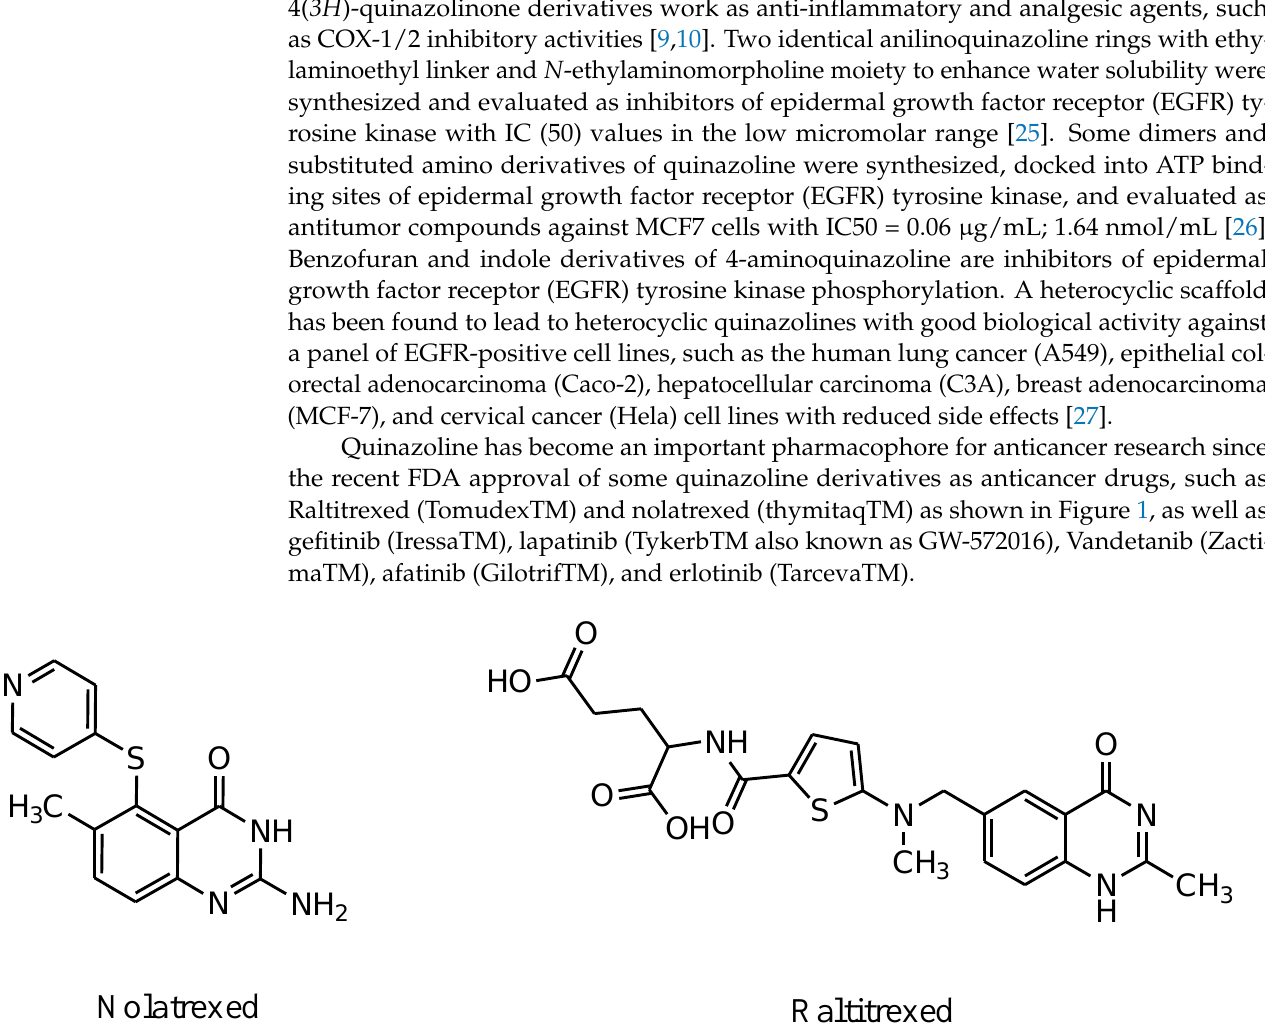
Figure 1. Chemical structure for some quinazoline derivatives used as anticancer drugs, such as nolatrexed and Raltitrexed. In our present study, we designed a number of quinazoline derivatives bearing trimethoxy phenyl moiety in position 2 and insertion of methoxy at position 8 to give different electronic, steric, and lipophilic characters that might help improve the antitumor activity of the newly designed scaffolds. In addition, we kept the substitution at position 3 in an attempt to get optimized quinazoline derivatives with promising anticancer activity (Figure